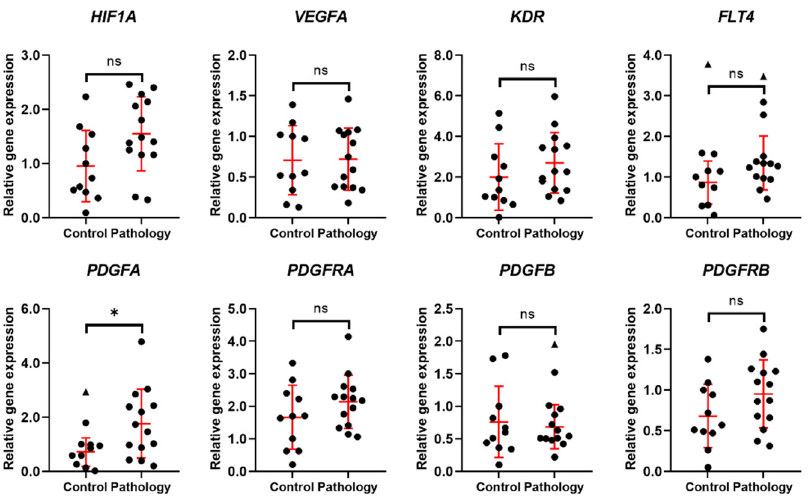
Figure 2. Expression of angiogenesis-related genes. Results are presented as mean ± standard deviation (red lines); triangle data points represent outliers based on ROUT (Q = 5%). In the control group, n = 11; in the pathology group, n = 14. * p ≤ 0.05; ns—not statistically significant, based on the Mann–Whitney U